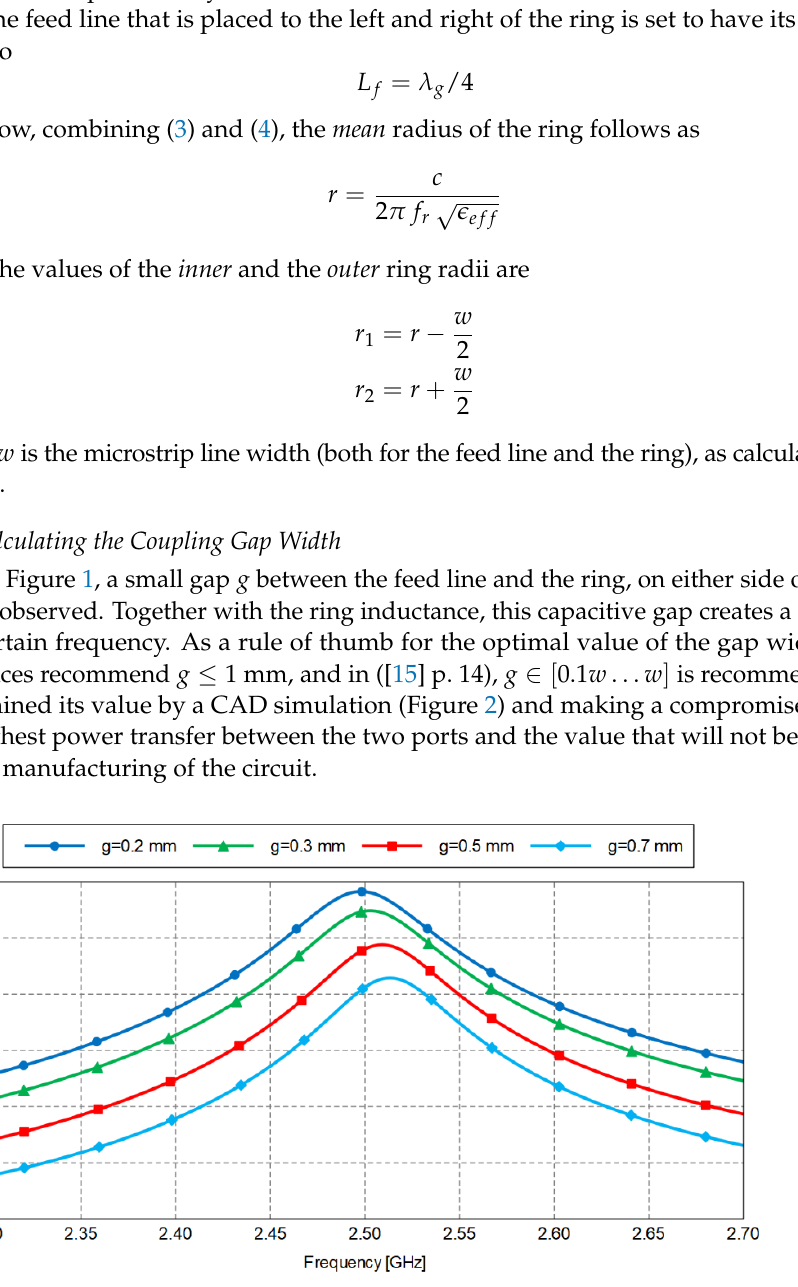
Figure 2. Optimization of the gap value by a full-wave